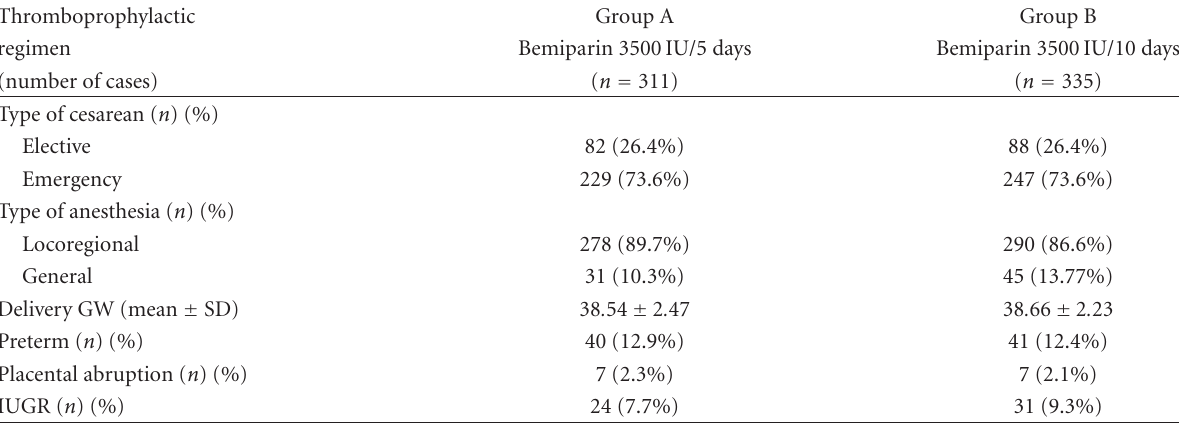
Table 2: Characteristics of the surgery by study group and thrombosis risk factors during the cesarean.